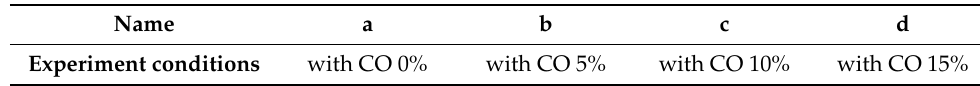
Table 2. Types of samples analyzed by EDS, XRD.